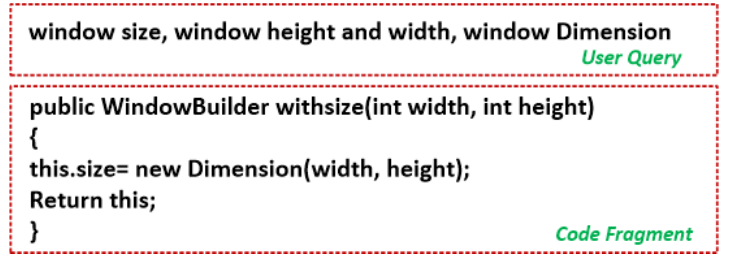
Figure 2. Component Retrieval